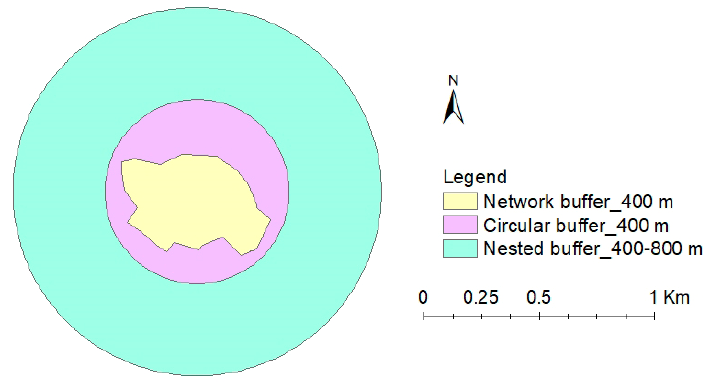
Figure 2. An example map of three types of buffers.